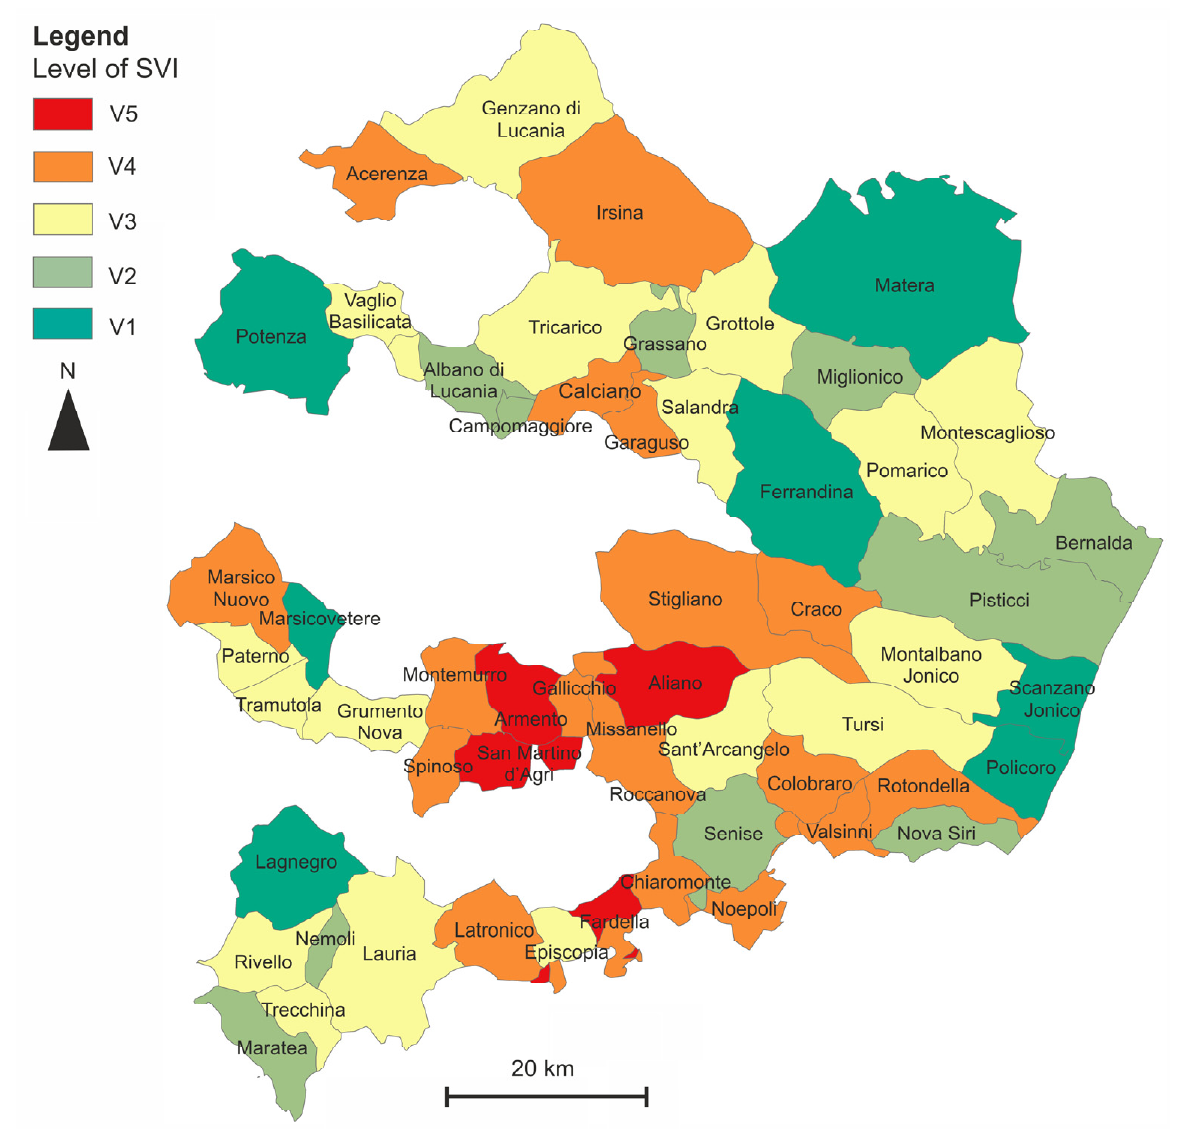
Figure 7. Spatial distribution of social vulnerability index across the study area. V1 = very low social vulnerability, V2 = low social vulnerability, V3 = medium social vulnerability, V4 = high social vulnerability, V5 = very high social vulnerability.